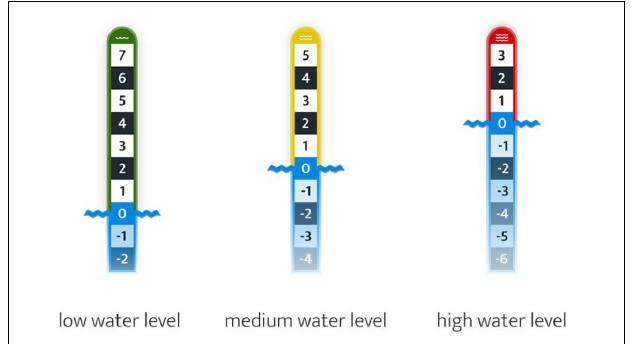
FIGURE 6 | The three staff gauges available in the app. Their ideal application depends on the flow condition of the river at the time that the reference picture is taken. Design/author: Philipp Hummer, SPOTTERON Citizen Science, www.spotteron.net.